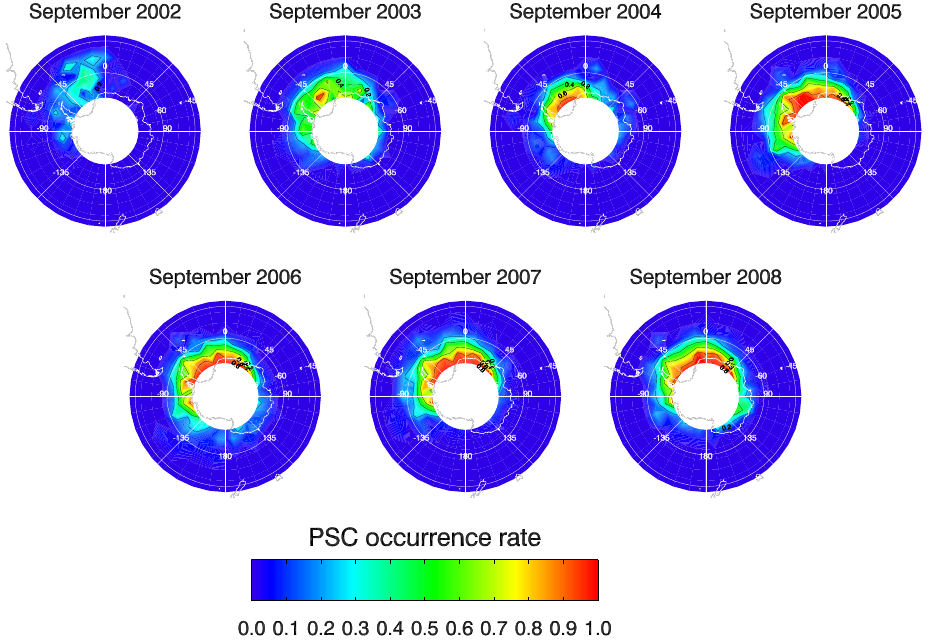
Fig. 10. Maps of PSC occurrence rates in the southern polar atmosphere for September of the years 2002–2008. Contour levels are 0.2, 0.4, 0.6 and 0.8. Meridians are displayed in steps of 45 ◦ and latitude circles are shown for 45 ◦ S and 60 ◦ S.